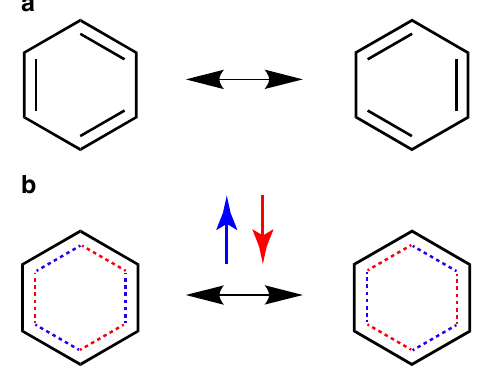
Fig. 5 Diagrammatical depictions of resonance in benzene. a The classical Kekulé structures. b The description suggested here, where different spins are coloured red and